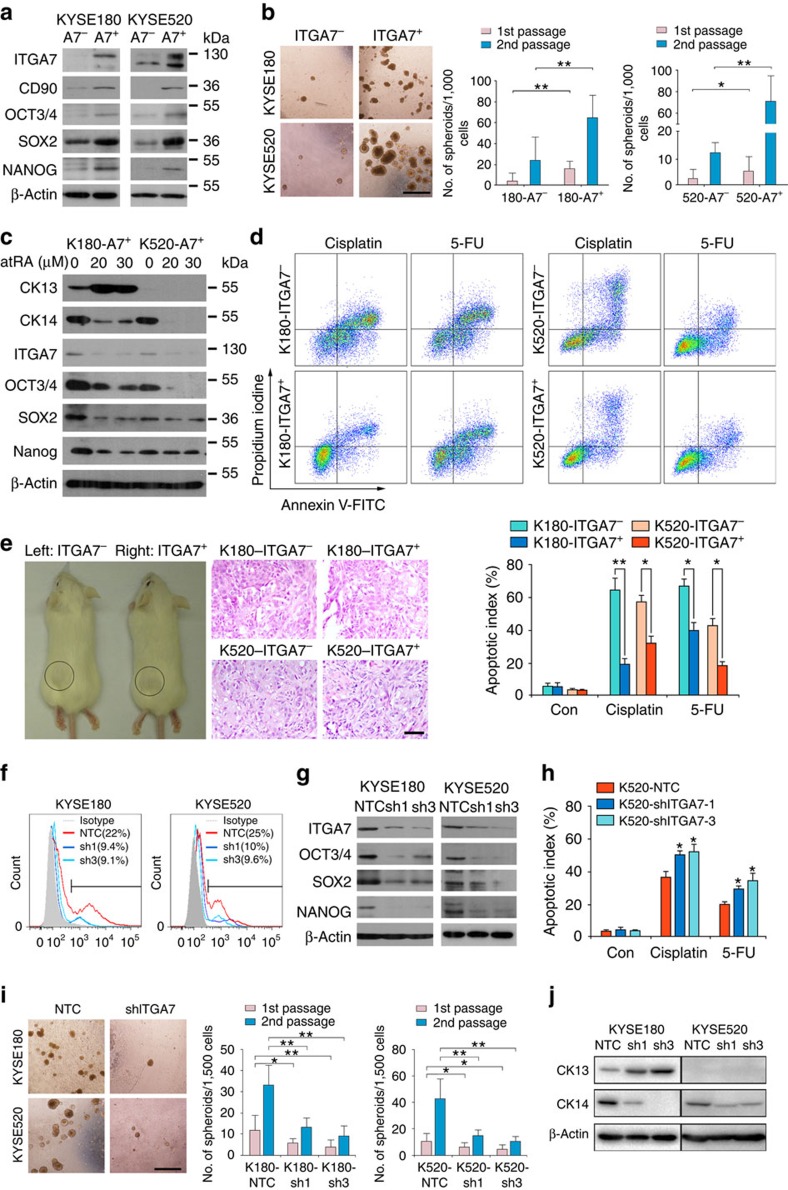
ITGA7+ OSCC cells possess the CSC properties, while knockdown of ITGA7 reduces CSC properties.(a) FACS sorted ITGA7+ cells from KYSE180 and KYSE520 showed higher expression level of stemness-associated genes and CD90, compared with ITGA7− cells. β-Actin was used as a loading control. (b) By spheroid formation assay, the self-renewal ability was enhanced in ITGA7+ cells. Secondary spheroids formed from dissociating spheroids also demonstrated enhanced serial spheroid-forming capacity. The values indicate the mean±s.d. of two separate experiments with 24 wells per condition. Scale bar, 500 μm. (c) On induced by differentiation drug atRA for 5 days, expression of CK13 and CK14 was increased (no CK13 expression in KYSE520) and decreased in ITGA7+ cells, respectively. Decreased expression of ITGA7 and stemness-associated genes was also detected in ITGA7+ cells. (d) Representative of apoptosis analyses showing that ITGA7+ cells were more resistant to chemotherapeutic drugs, compared with ITGA7− cells. The apoptotic index was summarized in the bar chart and the value indicated the mean±s.d. of three independent experiments. (e) Representative of tumours formed in NOD/SCID mice injected with the indicated cells. H&E staining of tumours confirmed a malignant phenotype. Scale bar, 50 μm. (f,g) shRNA-mediated ITGA7 silencing was confirmed by FACS and western blot analysis. The expression of stemness-associated genes was decreased in shITGA7-transfected cells, compared with non-target control (NTC). (h) The summary of apoptotic index showing that ITGA7 silencing decreased the chemoresistance of KYSE520 cells. The value indicated the mean±s.d. of three independent experiments. (i) Spheroid formation assay showed that the self-renewal ability was decreased in ITGA7 silencing cells. The values indicate the mean±s.d. of two separate experiments with 24 wells per condition. Scale bar, 500 μm. (j) Knockdown of ITGA7 promoted the differentiation of OSCC cells. CK13 and CK14 is a well and poor differentiation marker in OSCC, respectively. Statistics: (b, d) Student t-test. (h,i) ANOVA with post hoc test. *P<0.05; **P<0.001.